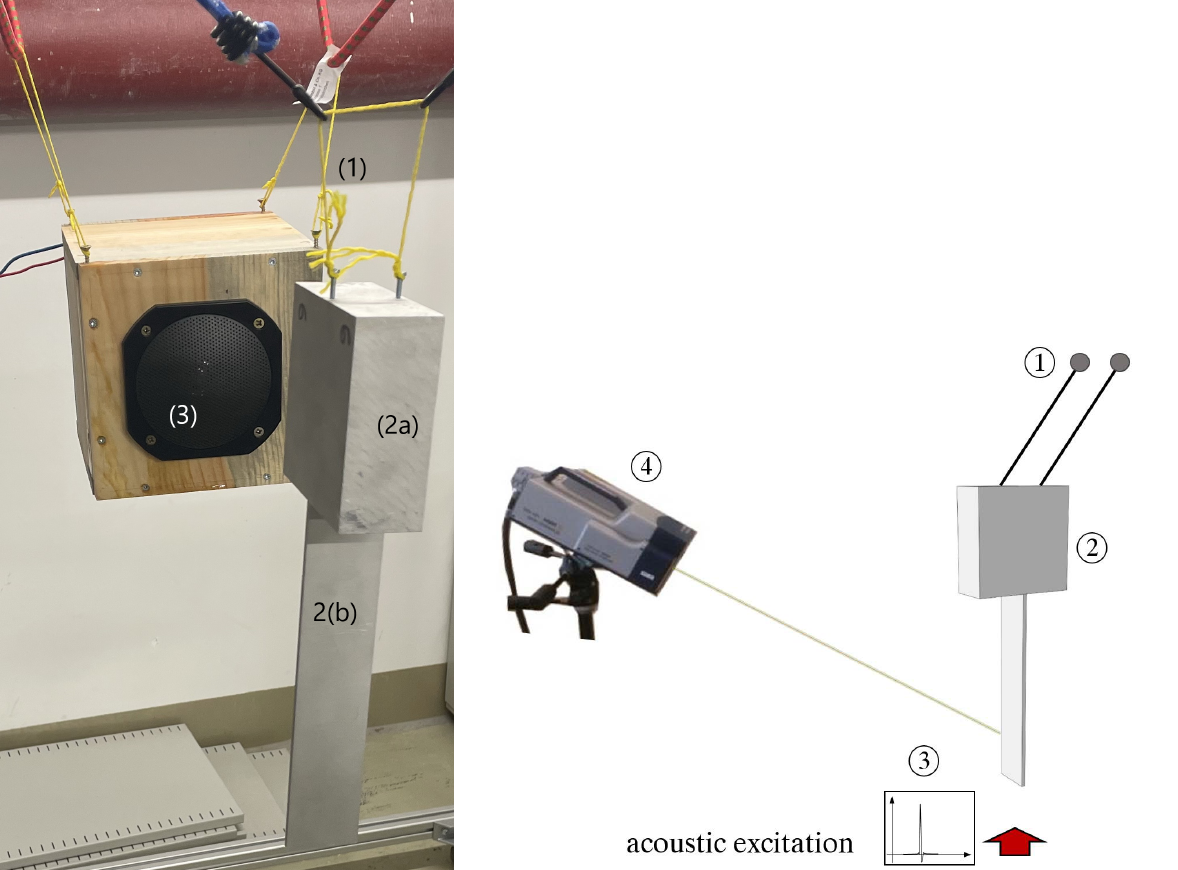
Figure 2. Image and sketch of the experimental setup showing: elastic strings (1), specimen mass (2a), specimen beam (2b), acoustic excitation (3), and laser Doppler vibrometer